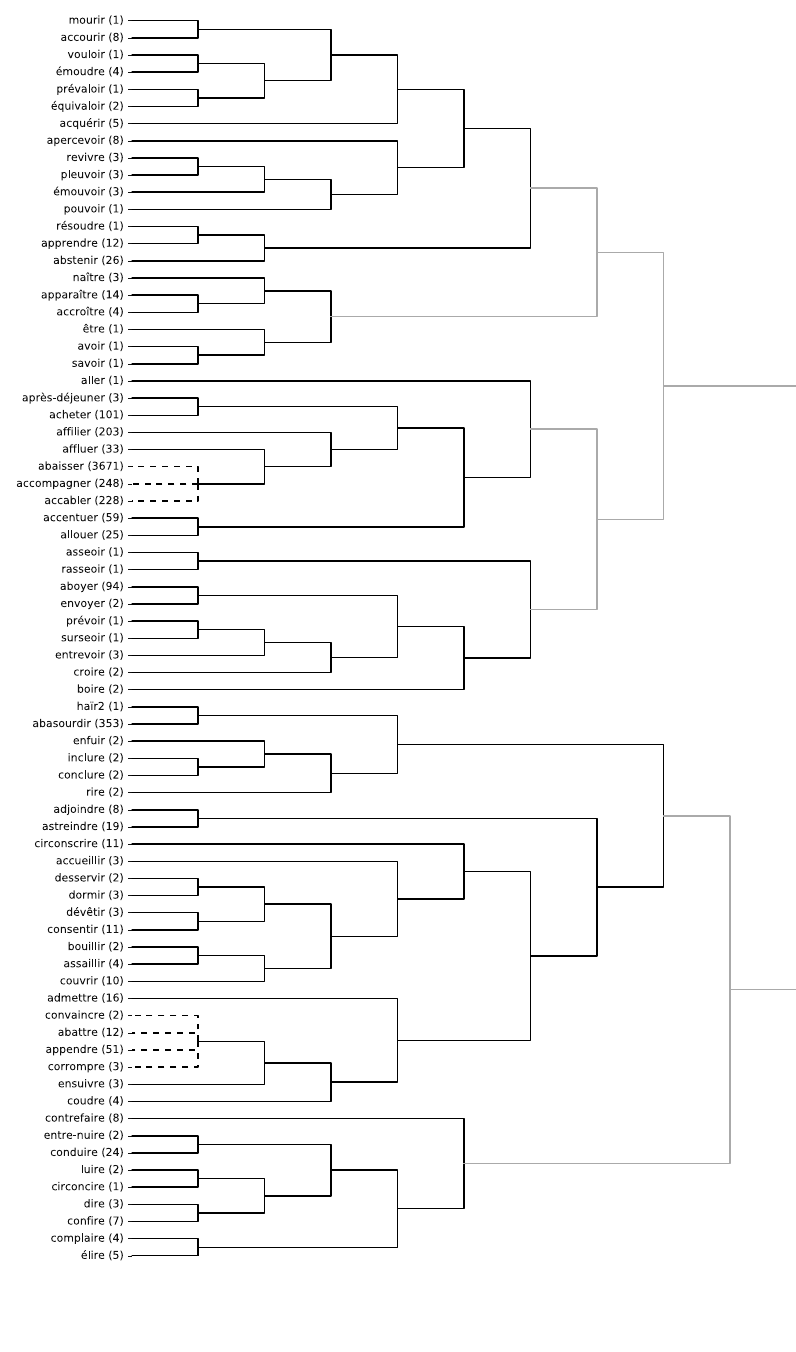
Figure 7: Intersection of the history of 100 runs for the French local patterns